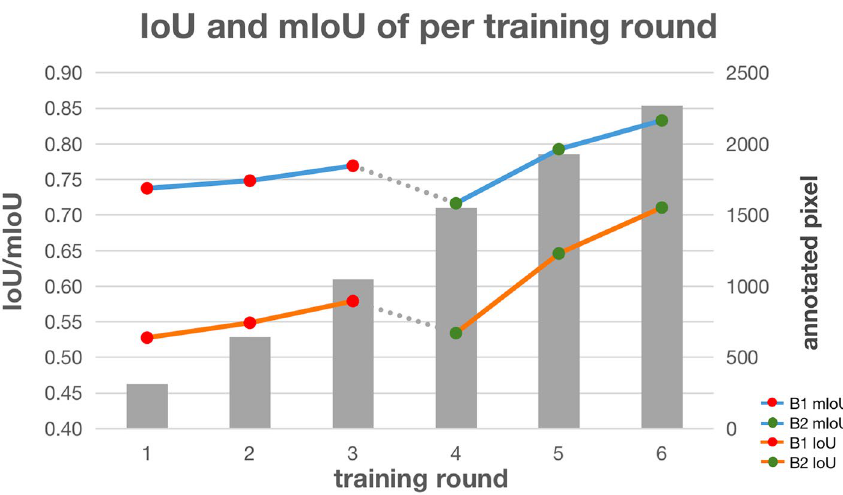
Figure 3. The IoU, mIoU and annoteted pixels of group B after 6 training rounds. The gray bar indicates the cumulative number of annotated pixels, i.e., the annotation